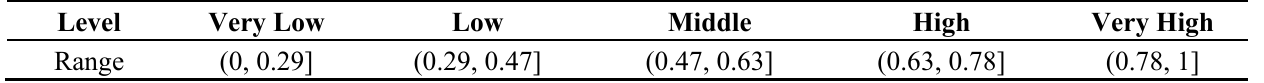
Table 3. Grading standards of the desertification disaster risk in Naiman